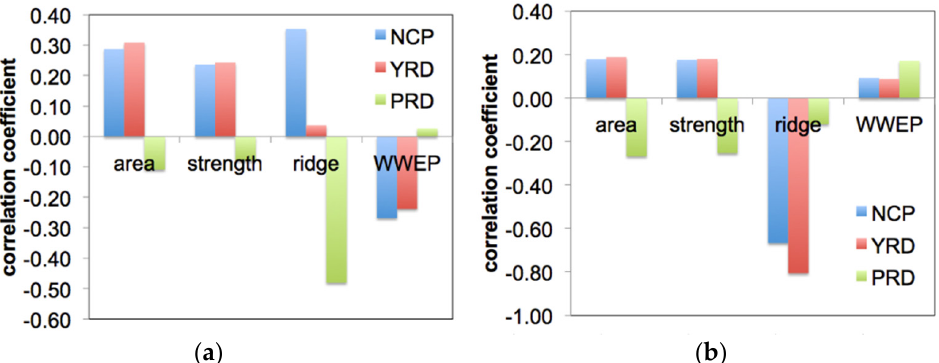
Figure 3. Correlation coefficients of AOD ( a ) and surface PM 2.5 ( b ) with area, strength, ridge position, and western extension index of Western Pacific sub-tropical high system in spring. Table 4. Correlation coefficients of seasonal mean AOD and surface PM 2.5 between 2006 and 2017 among NCP, YRD, and PRD.